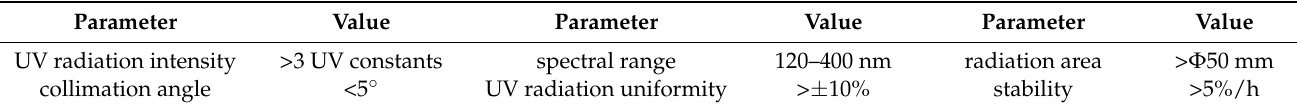
Table 1. Technical parameters of space UV radiation simulation device.